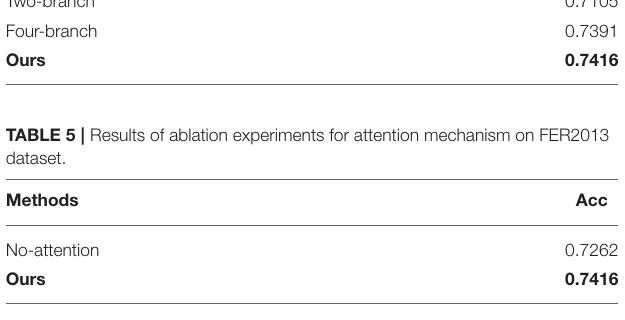
FIGURE 10 | FER2013 training data distribution.